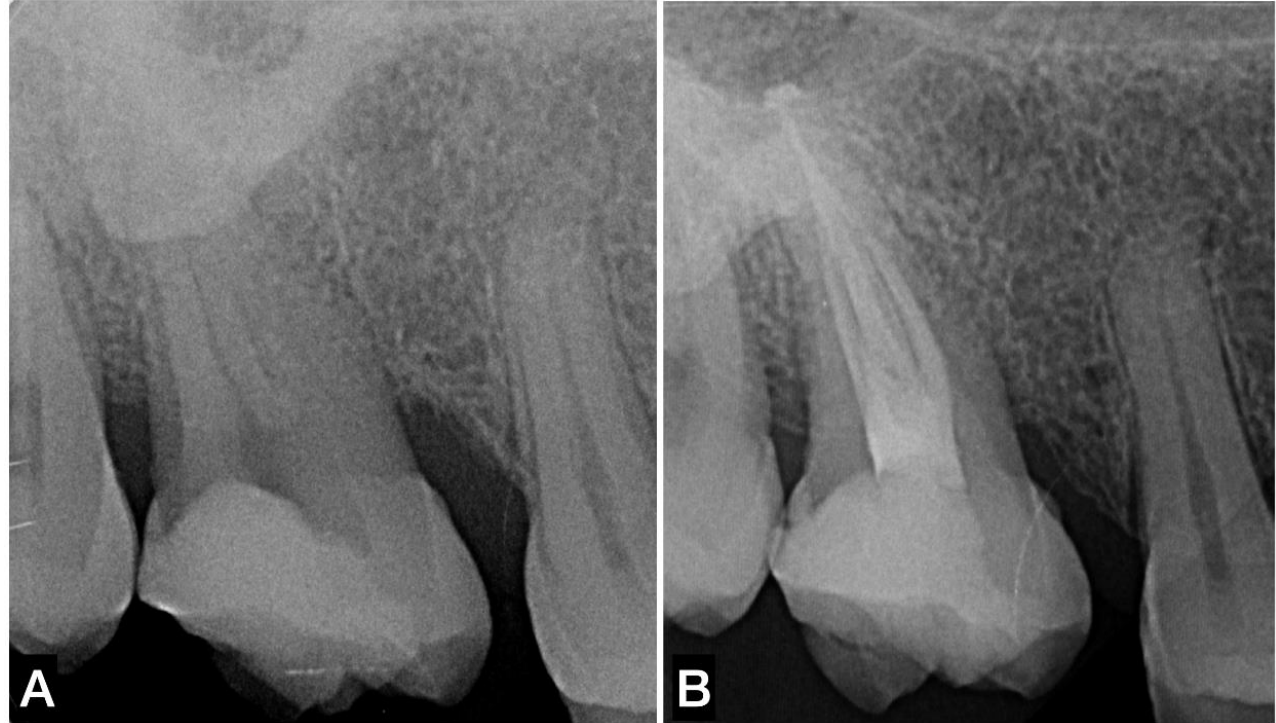
Figure 4. Example of indication of the single-cone technique with CSBS. ( A ) Preoperative periapical radiograph of a necrotic maxillary molar with long roots, sinus proximity, and patient’s limited mouth opening. ( B ) Postoperative periapical radiograph of root canal obturation using CSBS.